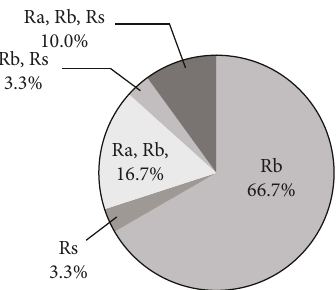
Figure 2: Pie chart depicting the location of rectal ulcer in 30 of 38 patients with acute hemorrhagic rectal ulcer syndrome (in 8 cases, rectal ulcer location was not described in endoscopy report). Rs: rectosigmoid; Ra: rectum above the peritoneal re fl ection; Rb: rectum below the peritoneal re fl